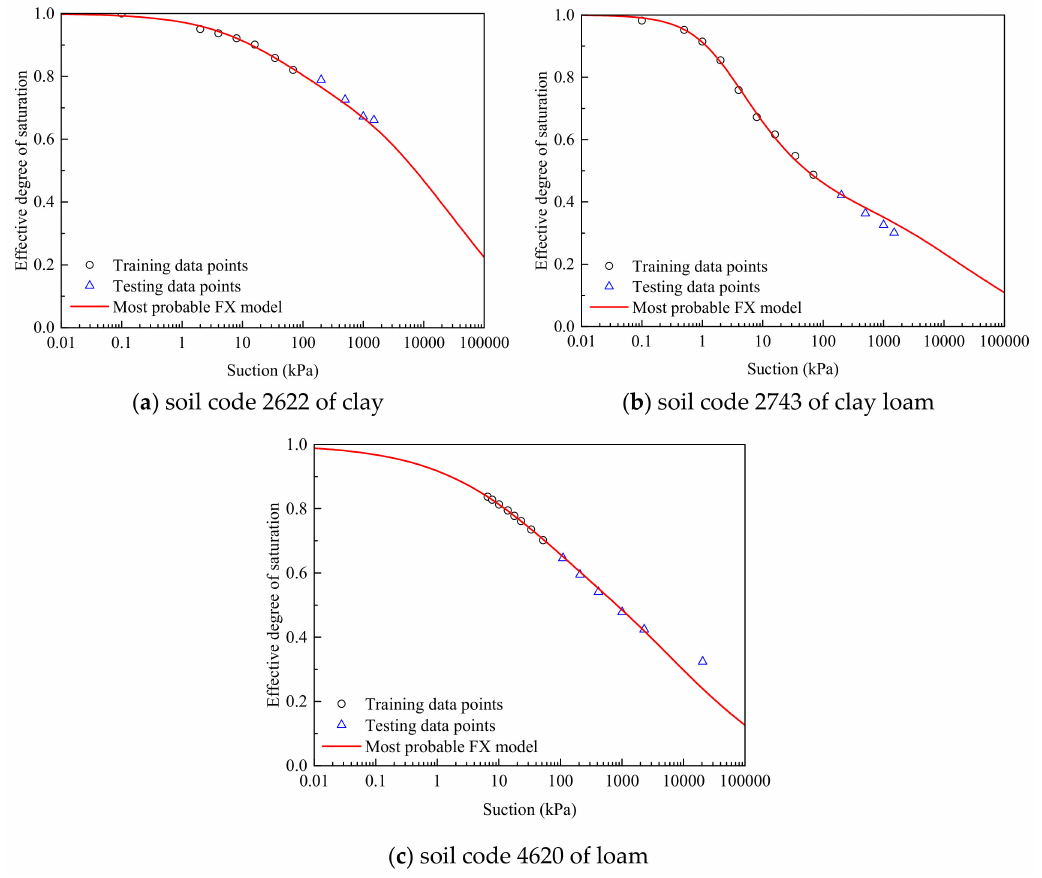
Figure 4. Prediction of SWCC in the high suction